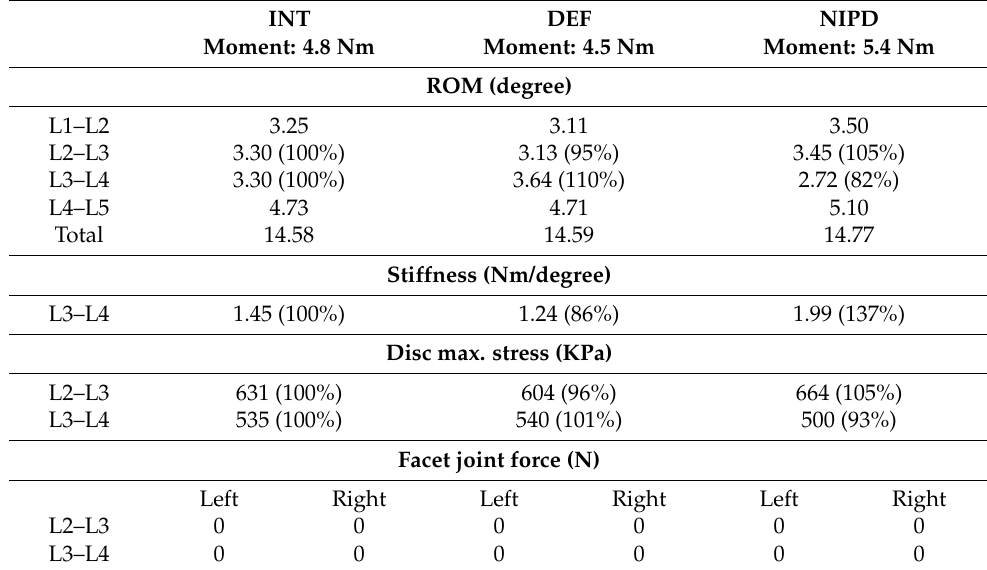
Table 2. Comparison of the biomechanical characteristics among the three FE models in flexion.